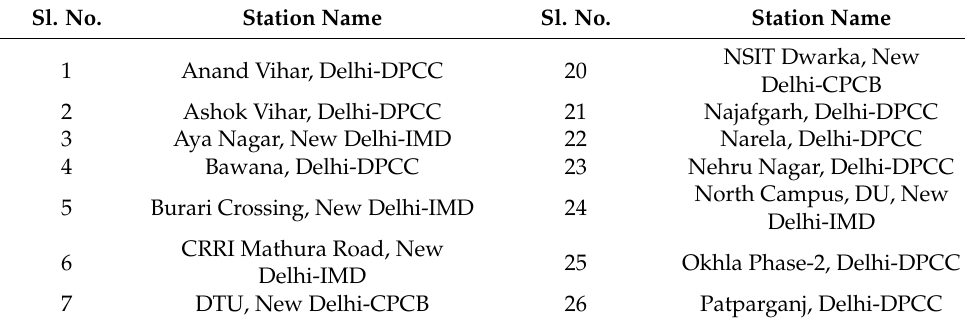
Figure 4. The overall methodology used in this study. Table 1. List of Continuous Air Quality Monitoring Stations (CAQM) stations maintained by the Central Pollution Control Board (CPCB), Delhi Pollution Control Committee (DPCC), and India Meteorological Department (IMD).